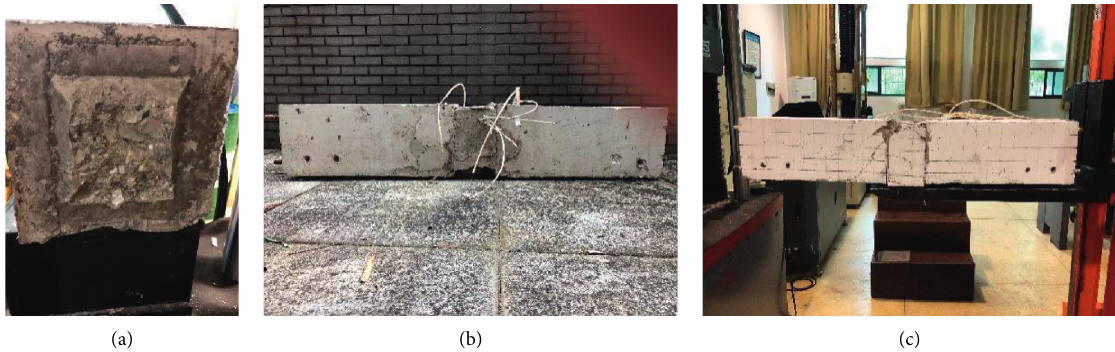
Figure 10: Failure modes for the specimens. (a) Type 1. (b) Type 2. (c) Type 3.